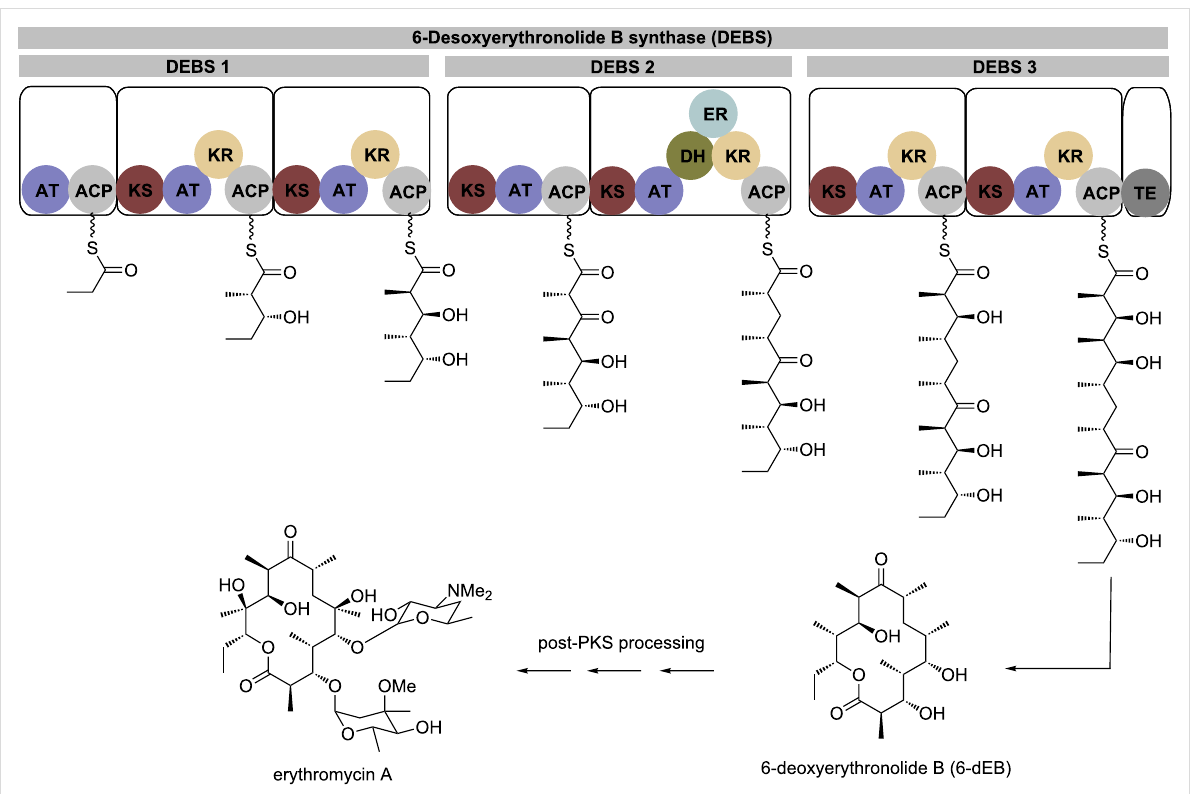
Figure 1: The most intensively studied PKS, deoxyerythronolide B synthase (DEBS), which catalyzes the key steps in the biosynthesis of the antibi- otic erythromycin. DEBS catalyzes the extension of a propionate starter unit with six equivalents of methylmalonyl-coenzyme A (MM-CoA). After six rounds of decarboxylative Claisen condensations and varying degrees of reduction of the initially formed β -keto thioesters, the polyketide core of erythromycin is released from the enzyme via a terminal esterase [6-8]. Abbreviations: AT: acyltransferase, ACP: acyl carrier protein, KS: ketosyn- thase, KR: ketoreductase, DH: dehydratase, ER: enoylreductase, TE: